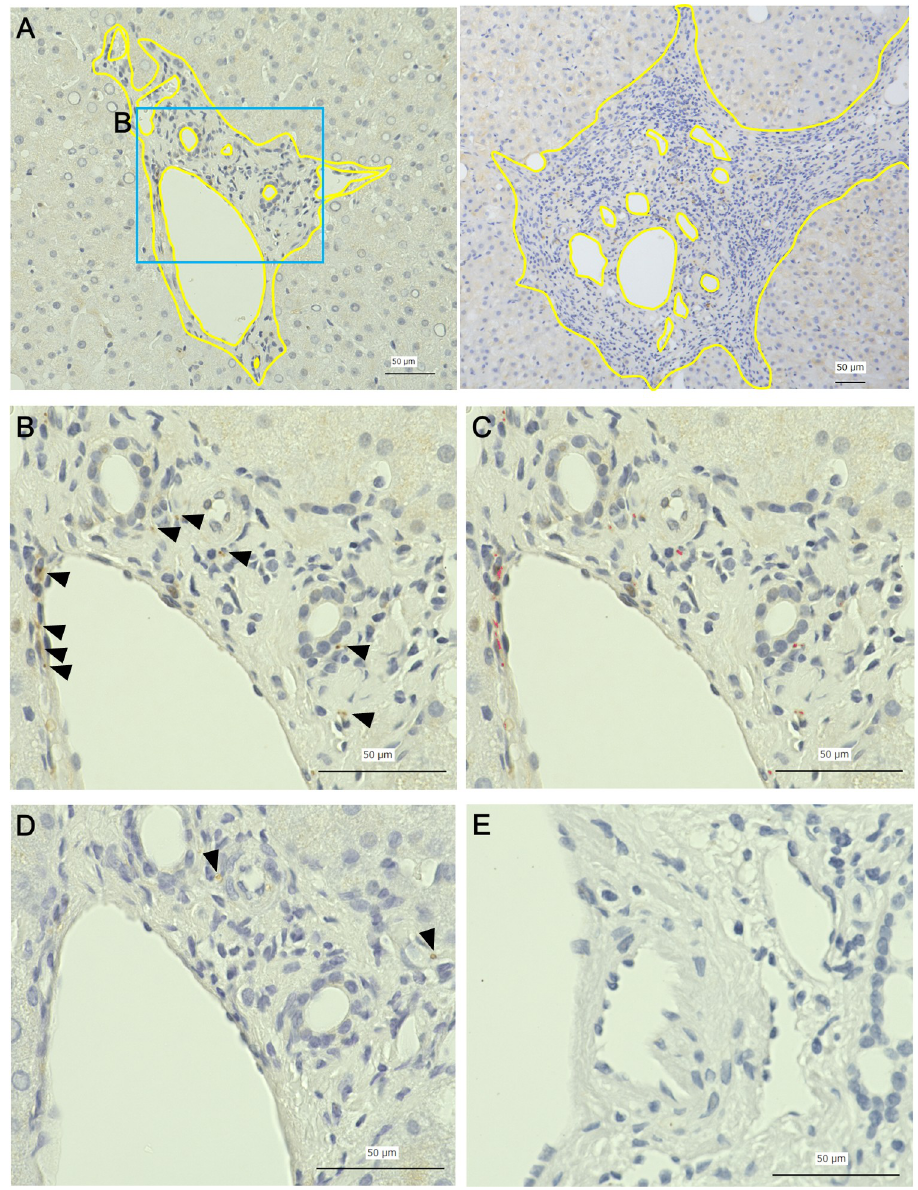
Fig 1. Quantitative measurement of intrahepatic nerve fibers. A: representative picture of the portal area (left: a case of mild fibrosis, right: a case of advanced fibrosis, yellow line: outer border of the portal area and border of the lumen), B: immunohistochemical staining for PGP9.5 (arrowheads), C: automatically detected area of immunohistochemically positive nerve fibers (red area), D: immunohistochemical staining for TH (arrowheads), E: negative control. Nerve fiber area ratio (NFAR) was obtained using the formula: NFAR = area of immunohistochemically positive nerve fibers ( μ m 2 )/ (portal area–vessel luminal area). Scale bars = 50 μ m.